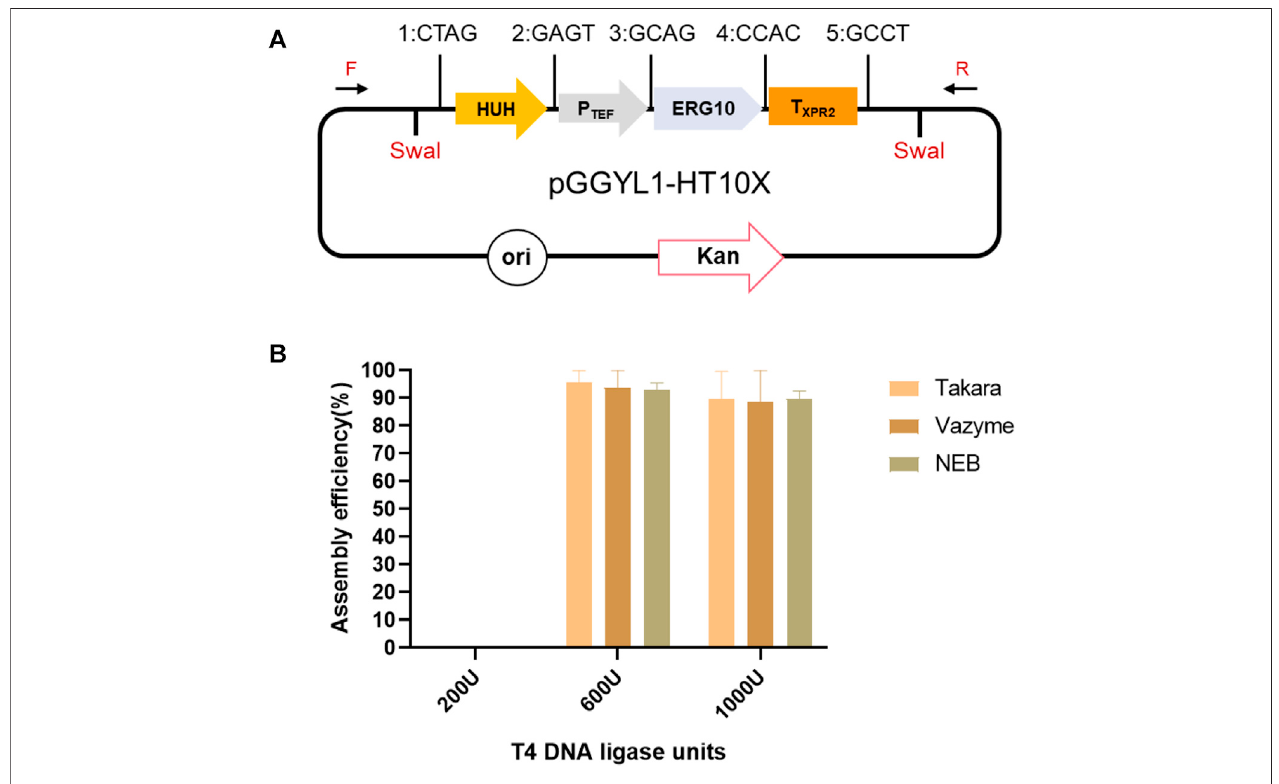
FIGURE2| AssemblyoffourfragmentsusingYALIcloneNHEJ. (A) SchematicrepresentationofthecompletelyassembledplasmidpGGYL1-HT10X. (B) Assembly ef fi ciency using different amounts of T4 DNA ligase from three commercial suppliers. The primers F/R were used to amplify the assembled fragments.